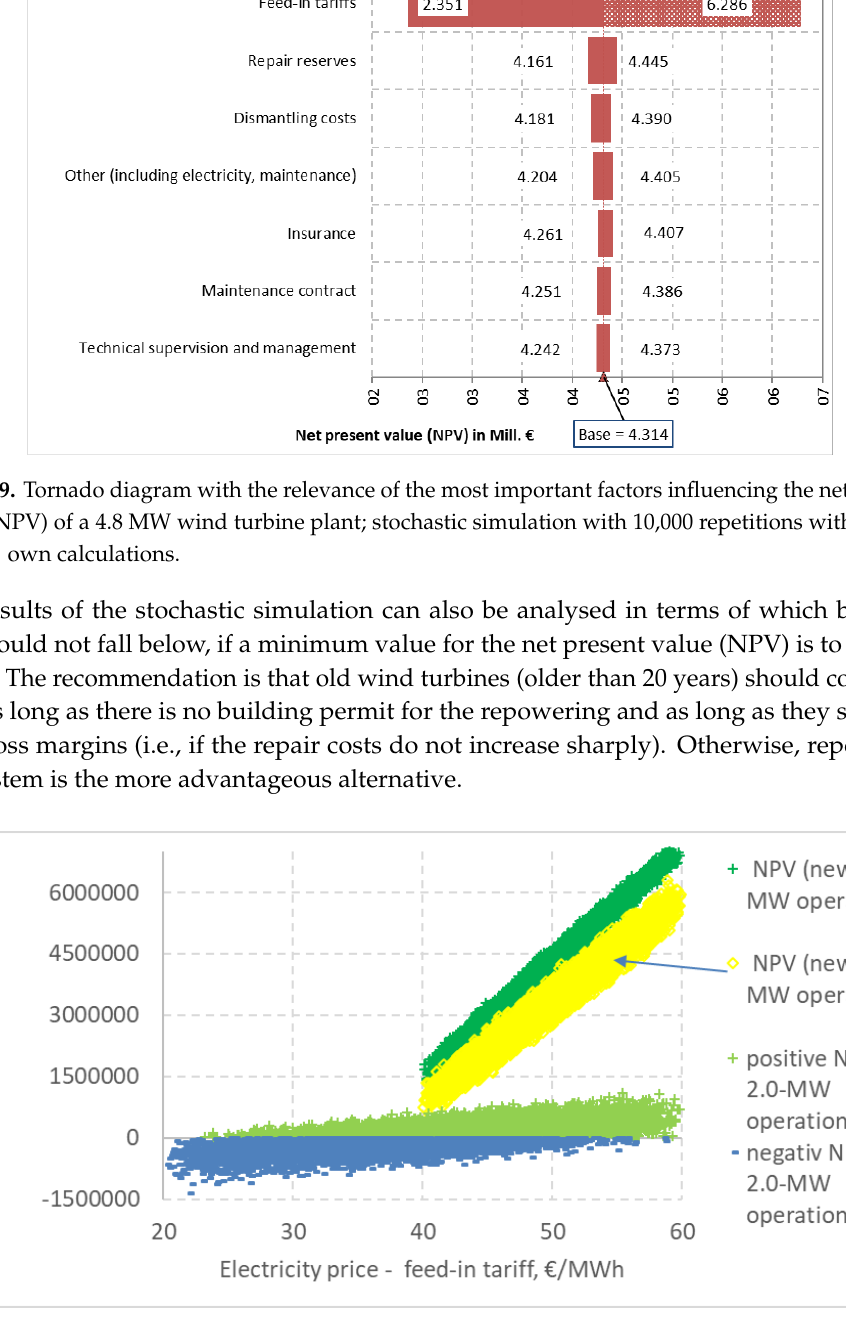
Figure 8. Distribution of the net present value (NPV) for three wind turbines with variable remuneration, operating costs, dismantling costs, and lease rate; stochastic simulation with 10,000 repetitions with @RISK; (Range 5%–95%). Source: own calculations.